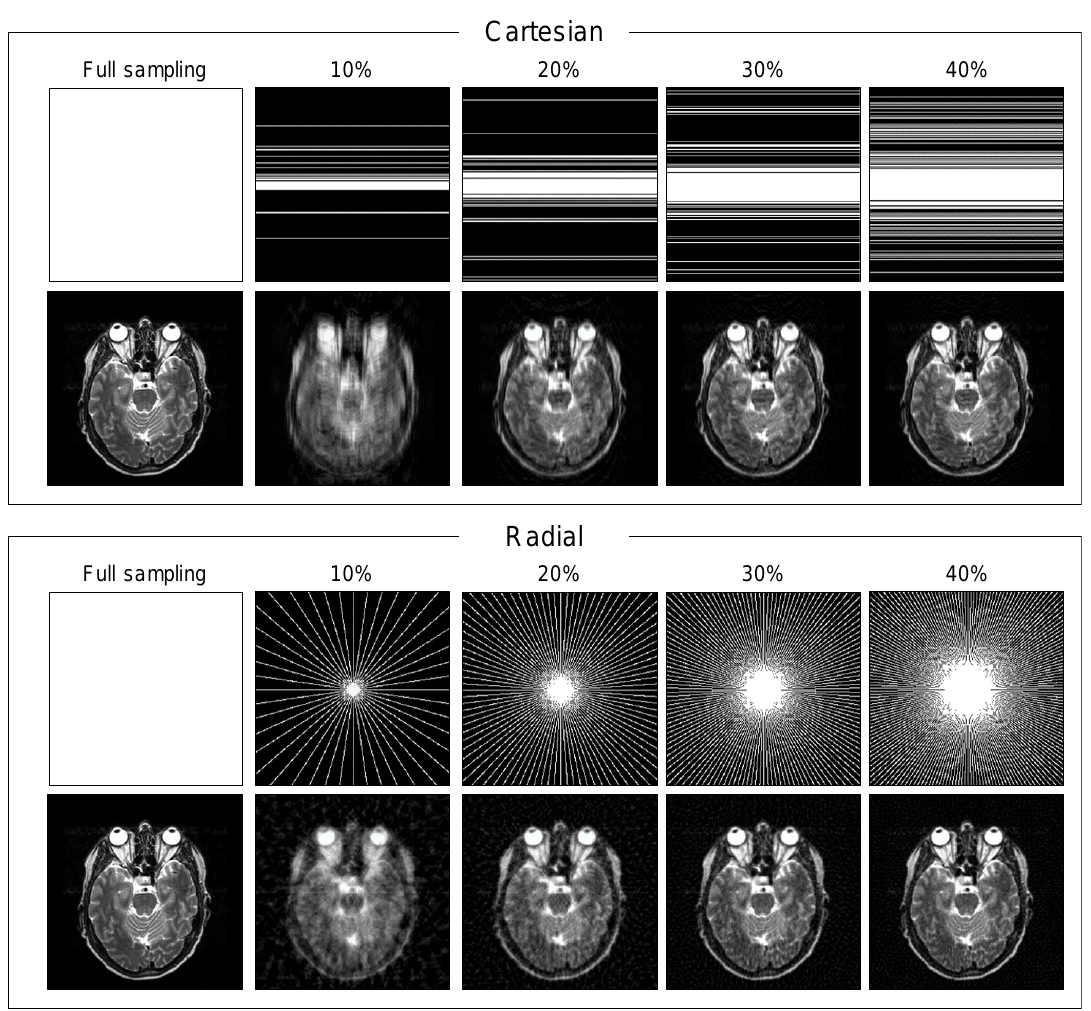
Figure 3. Cartesian and radial sampling masks for the different undersampling masks — 10%, 20%, 30%, and 40% — considered in this study.